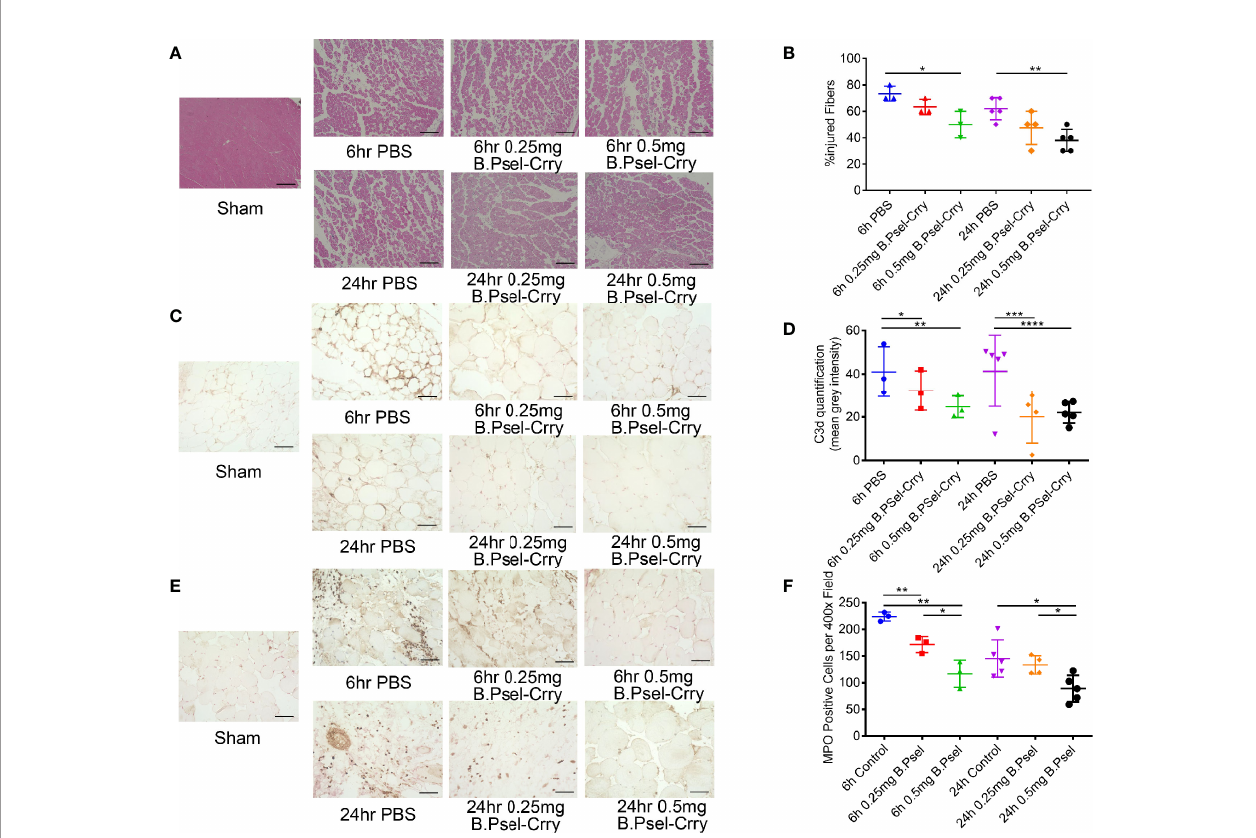
FIGURE 5 | B.PSel-Crry reduces hindlimb graft injury and in fl ammation following vascularized composite isograft transplantation. Tissue sections from the thigh muscle of hindlimb grafts isolated at either 6 h or 24 h post-transplant were prepared. (A) Representative H&E stained muscle sections demonstrating muscle necrosis and myeloid cells in fi ltrates in controls that are largely absent in 0.5mg B.PSel-Crry treated mice. Scale bars, 200 m m. (B) Quanti fi cation of injury shown as the percentage of injured fi bers from the total number of muscle fi bers counted in each tissue sample. Non-parametric One-Way ANOVA (Kruskal-Wallis) with Dunn ’ s correction. (C) Representative images of sections stained for C3d deposition. Scale bars, 50 m m. (D) Quanti fi cation of C3d staining by measuring mean fl uorescence intensity, showing a dose-dependent reduction in C3d by B.Psel-Crry treatment measured at both 6 hours and 24 hours. Parametric One-Way ANOVA with Tukey ’ s correction. (E) Representative images of sections stained for MPO. Scale bars, 50 m m. (F) MPO quanti fi cation represented as number of MPO positive cells per fi eld, showing a dose-dependent reduction in MPO by B.Psel-Crry treatment measured at both 6 hours and 24 hours. Parametric One-Way ANOVA with Tukey ’ s correction. Quanti fi cation data expressed as Mean ± SD; *p ≤ 0.05, **p ≤ 0.01, ***p ≤ 0.001, ****p ≤